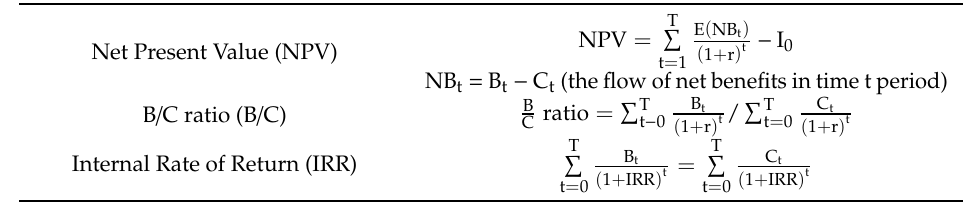
Table 1. Decision rules for CBA (Cost-Benefit